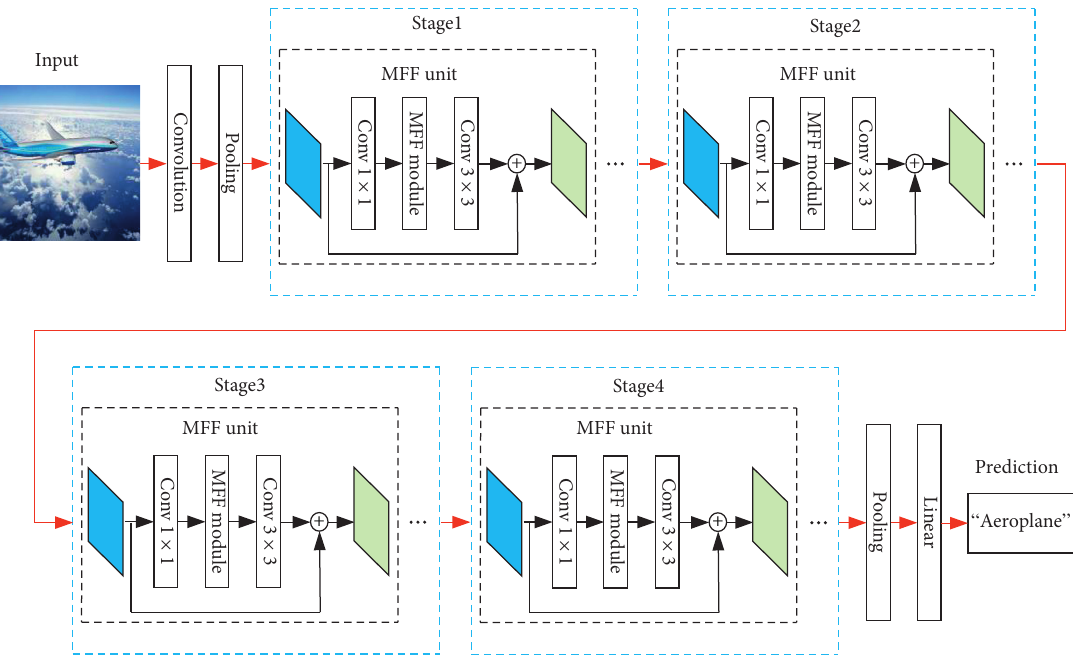
Figure 1: An MFFNet with four stages.